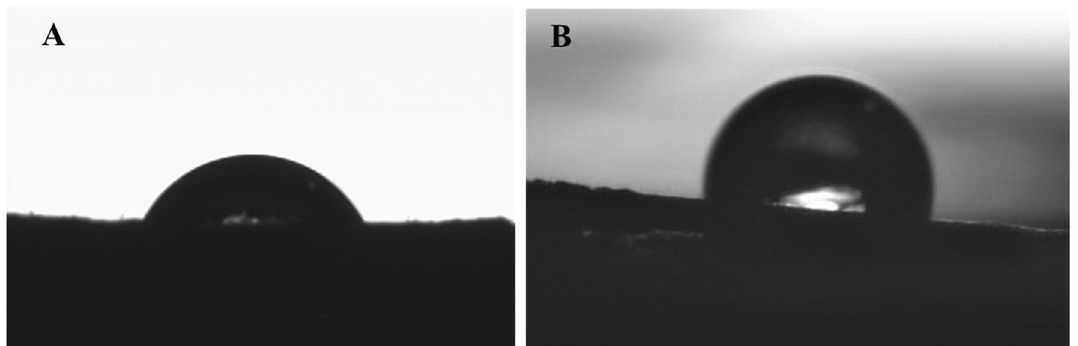
Figure 6. The contact angles of ( A ) raw DPF and ( B )